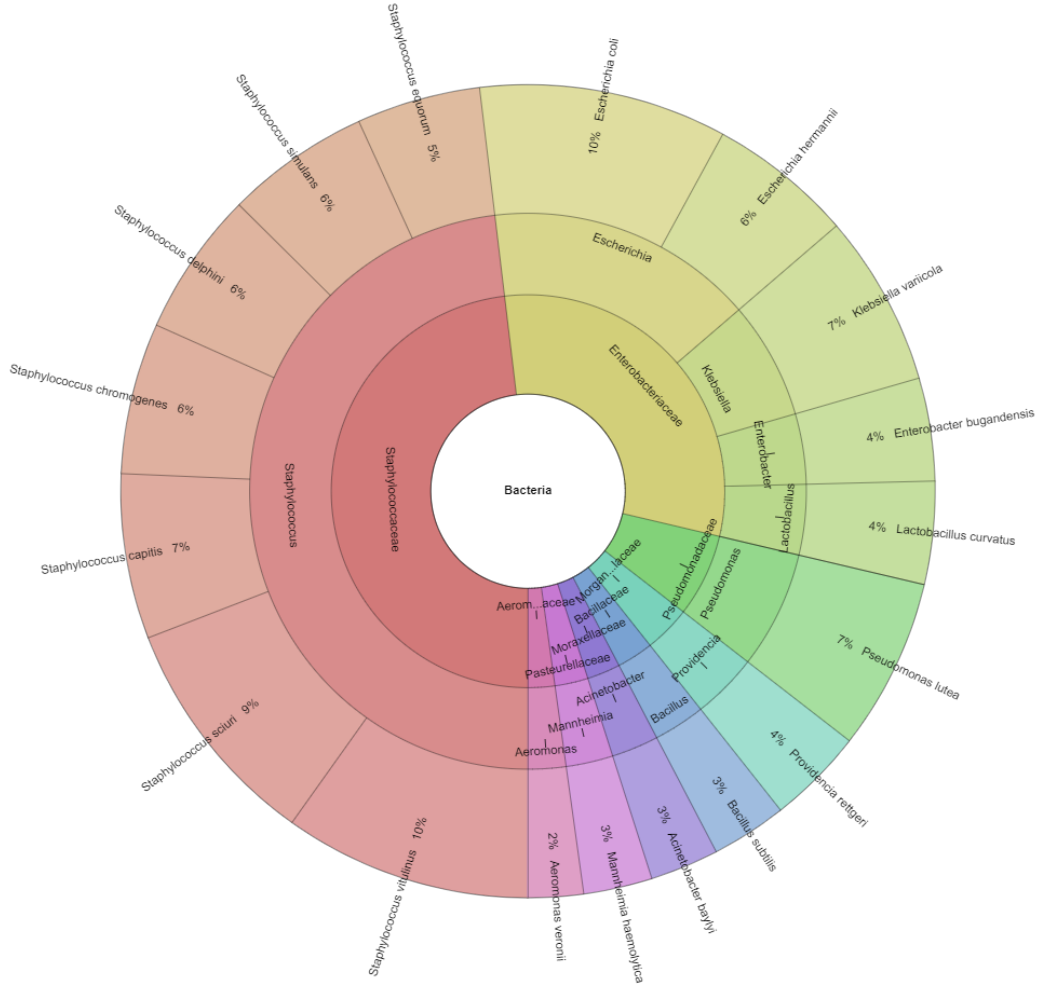
Figure 2. Krona chart of the bacteria represented by the MALDI-TOF MS Biotyper, recovered from ram semen (outermost ring: species, middle ring: genus, innermost ring: family).